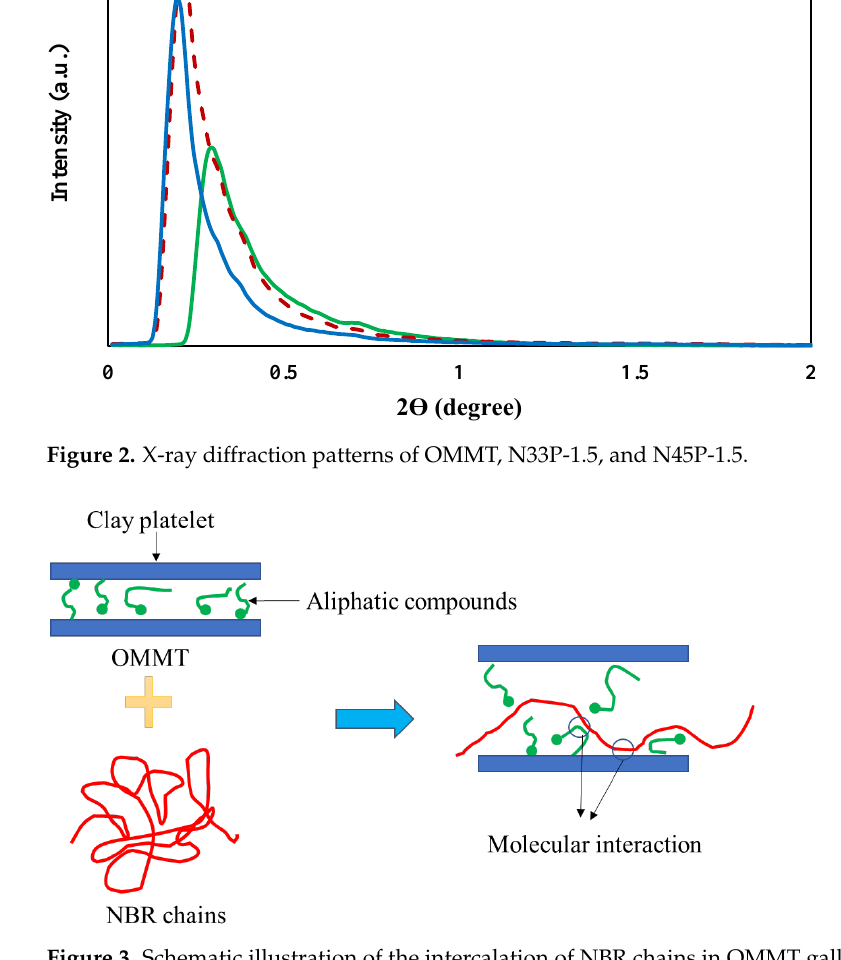
Figure 3. Schematic illustration of the intercalation of NBR chains in OMMT galleries .